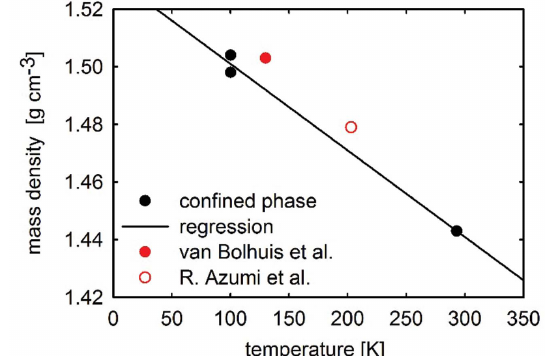
Figure 3 Calculated mass densities of the terthiophene phases as a function of temperature. The previously determined phase is represented by the red circles (van Bolhuis et al. , 1989; Azumi et al. , 2003), the surface-confined phase of this work is indicated by black circles.